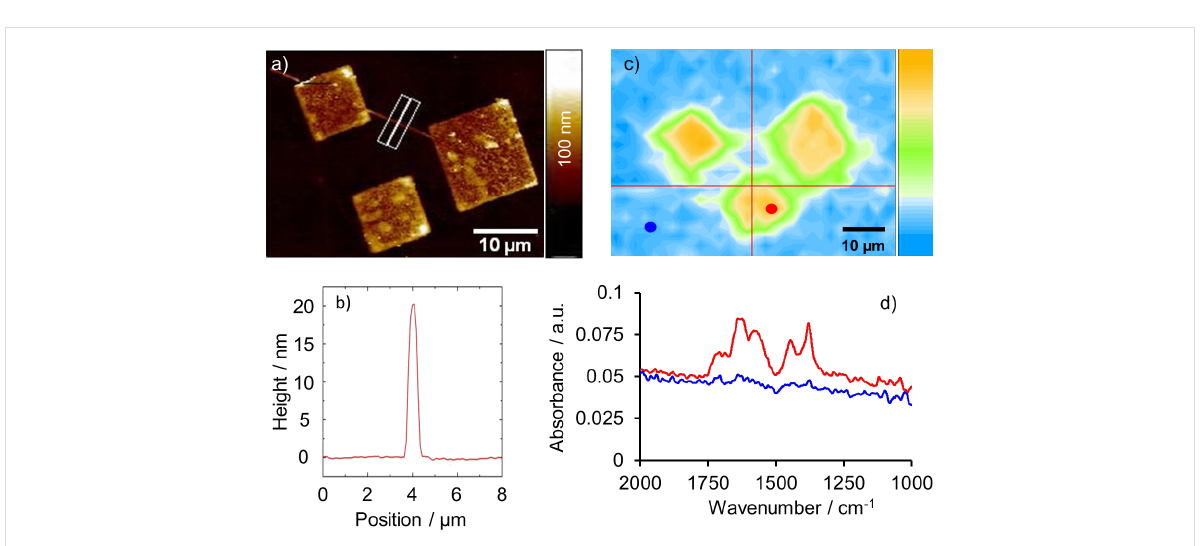
Figure 5: (a) AFM-topography image of HKUST-1 structures, prepared by spray coating after grafting squared areas of MPA into the DT matrix thiol. (b) Cross section along the white line of (a). (c) FT-IR imaging of the wavenumber region between 1510 cm − 1 and 1780 cm − 1 . (d) FT-IR spectra representing the area inside the squares (red line in (d) corresponding to red dot in (c)) and outside of the structures (blue line in (d), according to the blue dot in